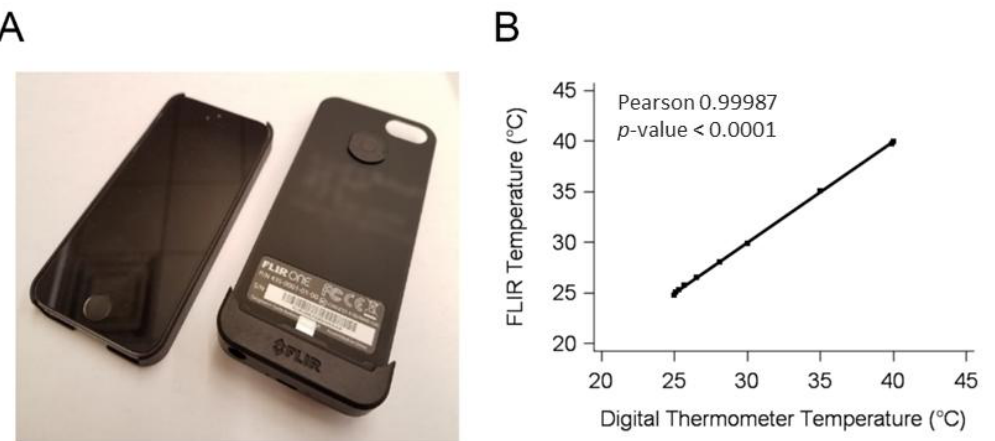
Figure 1. ( A ) The mobile thermal imager (FLIR ONE camera) on the right, and the compatible smartphone on the left (owner name and contact information was blurred from the image). The mobile thermal imager attaches to the back of the smartphone to create a single cohesive device. ( B ) Comparison between the infrared readings of a water bath taken by the mobile thermal imager and a digital thermometer.